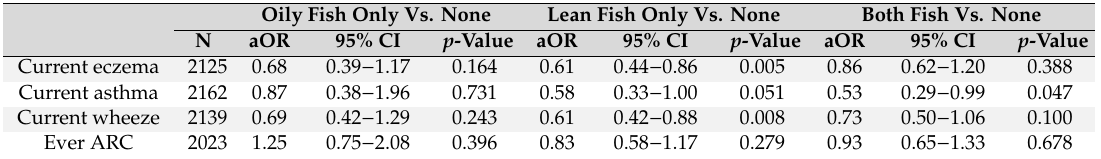
Table 3. Consumption of specific fish types at one year of age and allergy-related outcomes at six years of